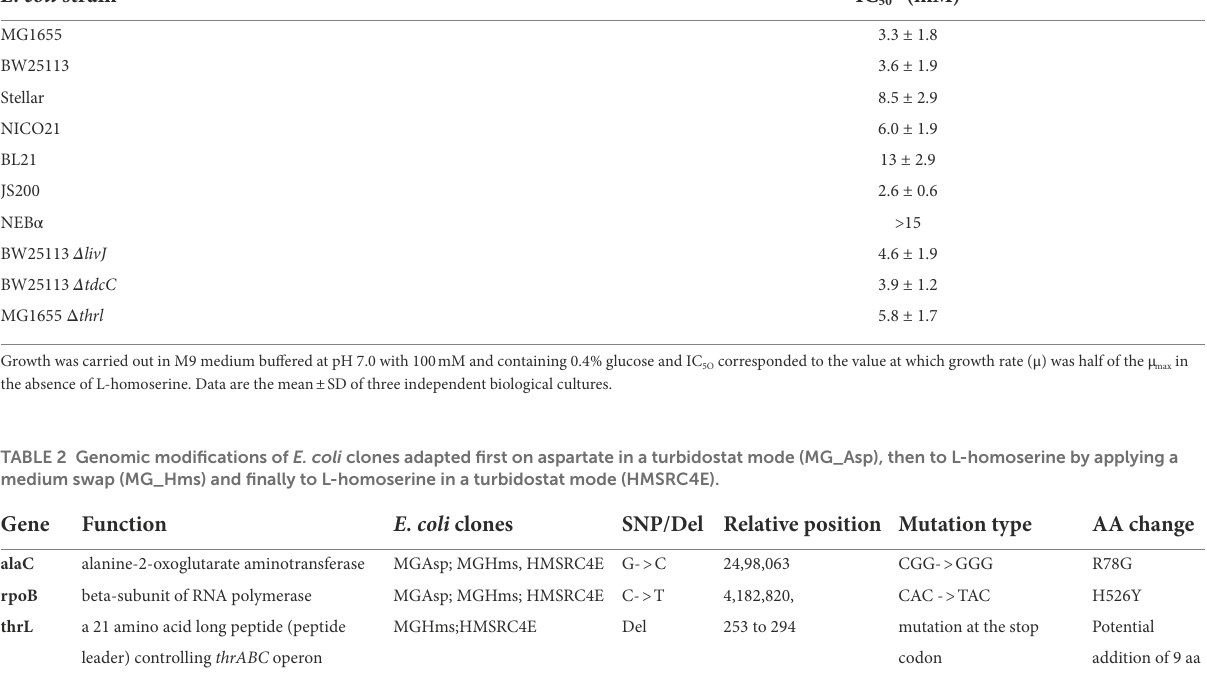
TABLE 1 Toxicity of L-homoserine on different E. coli strains as determined by the concentration at which this compound reduced by 50% the maximal growth rate (IC 50 ). E. coli